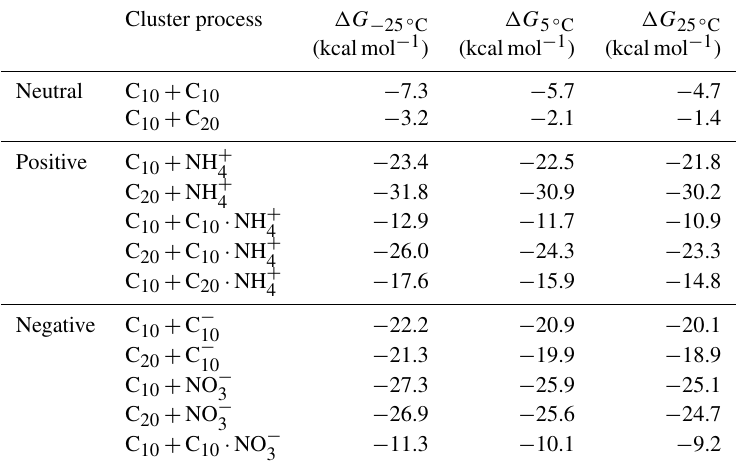
Table 3. Gibbs free energies of cluster formation (cid:49)G at three different temperatures. (cid:49)G for the molecules C 10 H 14 O 7 (C 10 ) and C 20 H 30 O 14 (C 20 ) forming neutral, as well as negative and positive ion